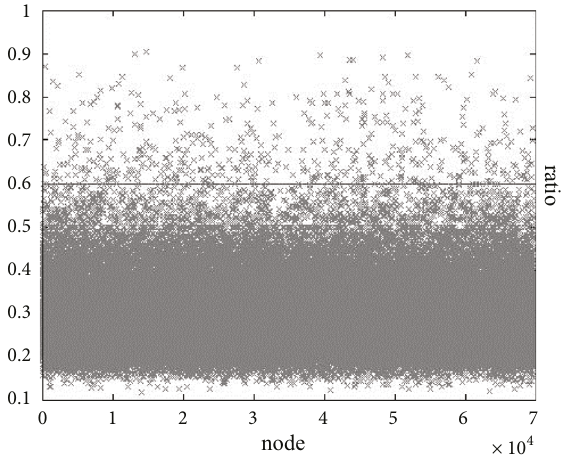
Figure 5: The distribution of different consumption